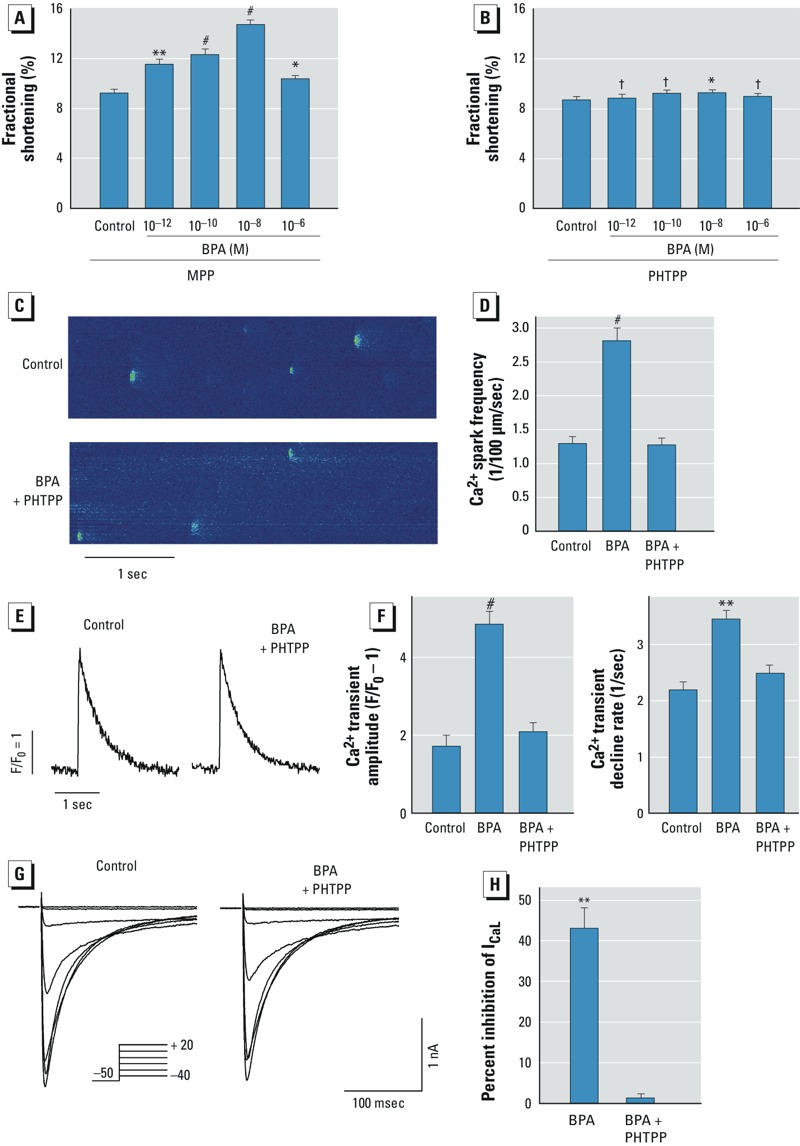
Mediation of the rapid effects of BPA by ERβ signaling in female rat myocytes. F/F0, fluorescence intensity ratio. (A,B) Effects of the ERα blocker MPP at 10–6 M (A) and the the ERβ blocker PHTPP at 5 × 10–6 M (B) on the dose response of BPA on myocyte contractility. For control and 10–12, 10–10, 10–8, and 10–6 M BPA, respectively, n = 39, 39, 41, 44, and 40 for (A), and 24, 24, 21, 24, and 22 for (B). (C) Ca2+ sparks recorded from a representative myocyte before and after exposure to 10–8 M BPA (1–2 min) plus PHTPP. (D) Average spark frequency in control, 10–8 M BPA, and BPA plus PHTPP; n = 9, 4, and 5 myocytes, respectively. (E) Representative Ca2+ transient traces in myocytes treated with control solution or BPA plus PHTPP. (F) Average Ca2+ transient amplitude (left) and decline rate (right) in control, 10–8 M BPA, and BPA plus PHTPP (n = 7, 9, and 9 myocytes, respectively. (G) Representative ICaL in control myocytes before and after treatment with BPA-plus-PHTPP. Inset: voltage clamp protocol. (H) Average inhibition of ICaL by 10–5 M BPA or BPA plus PHTPP; n = 6 and 3, respectively. Values are mean ± SE.
†p > 0.1. *p < 0.05, **p < 0.01, and #p < 0.001, compared with control by one-way ANOVA.